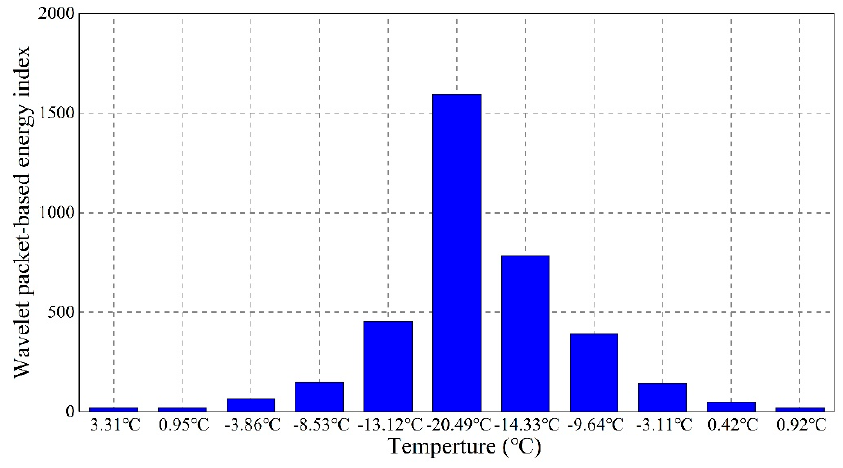
Figure 10. Variation of the wavelet packet energy index during the freeze–thaw process.